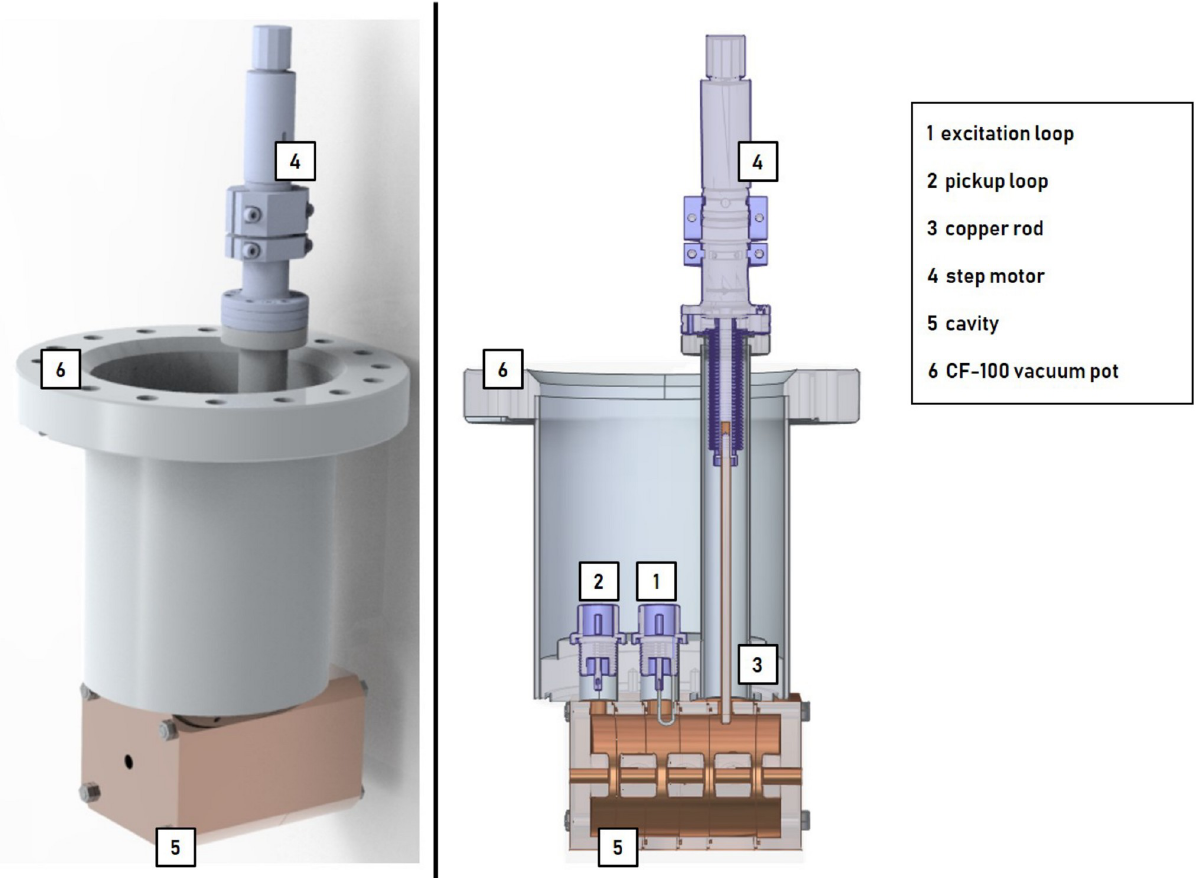
Fig 6. 4-gap buncher unit. Mounted on a CF-100 flange, the cavity can be installed directly in the beam tube. The vacuum pot provides pickup loop, excitation loop and variable tuner access to the cavity.